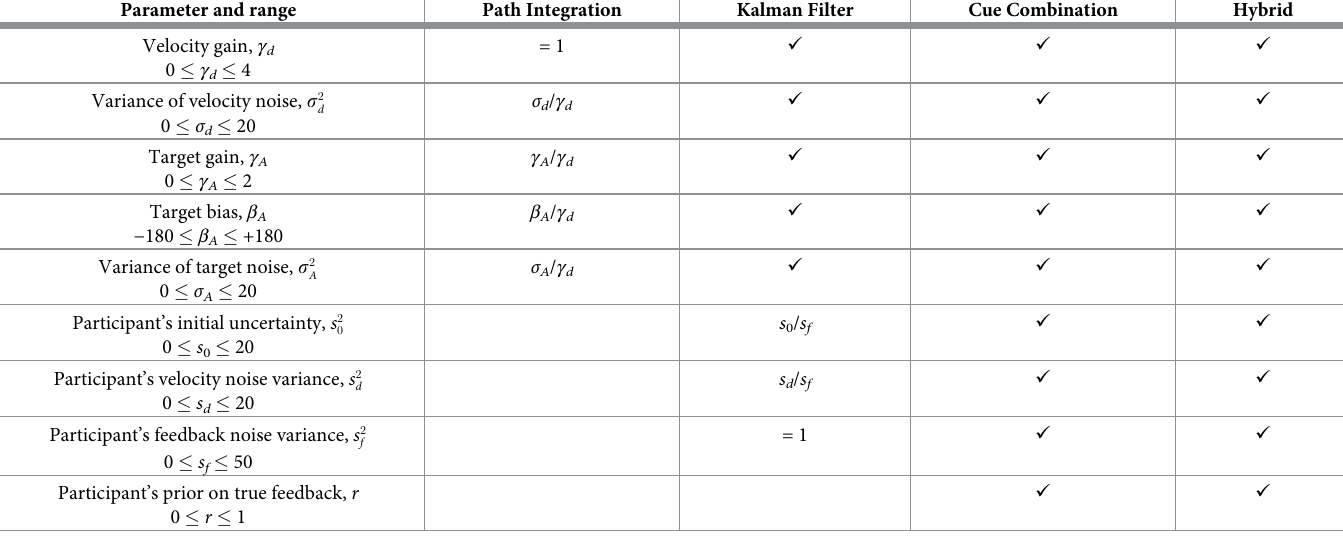
Table 2. Parameters, their ranges and values, in the different models. The presence of a parameter in a model is indicated by either a check mark (when it can be fit on its own), a ratio (when it can be fit as a ratio with another parameter), or = 1 when it takes the value 1. Parameter and range Path Integration Kalman Filter Cue Combination